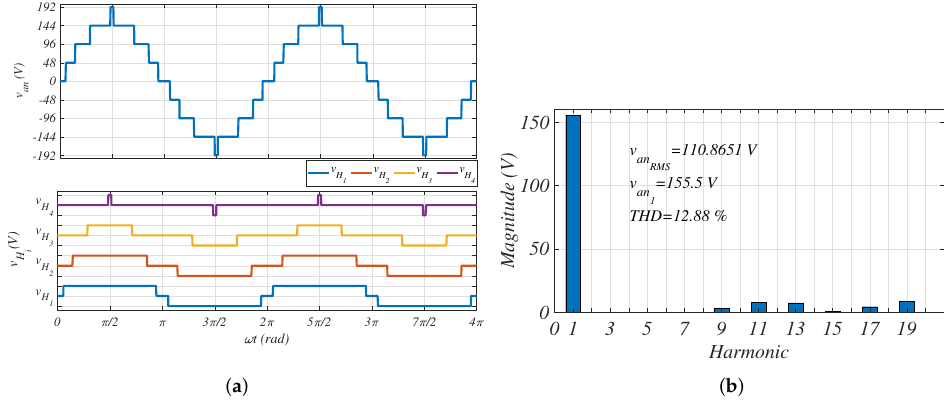
Figure 2. ( a ) Waveforms of v an , v H 1 , v H 2 , v H 3 , v H 4 , ( b ) Harmonics analysis of v an